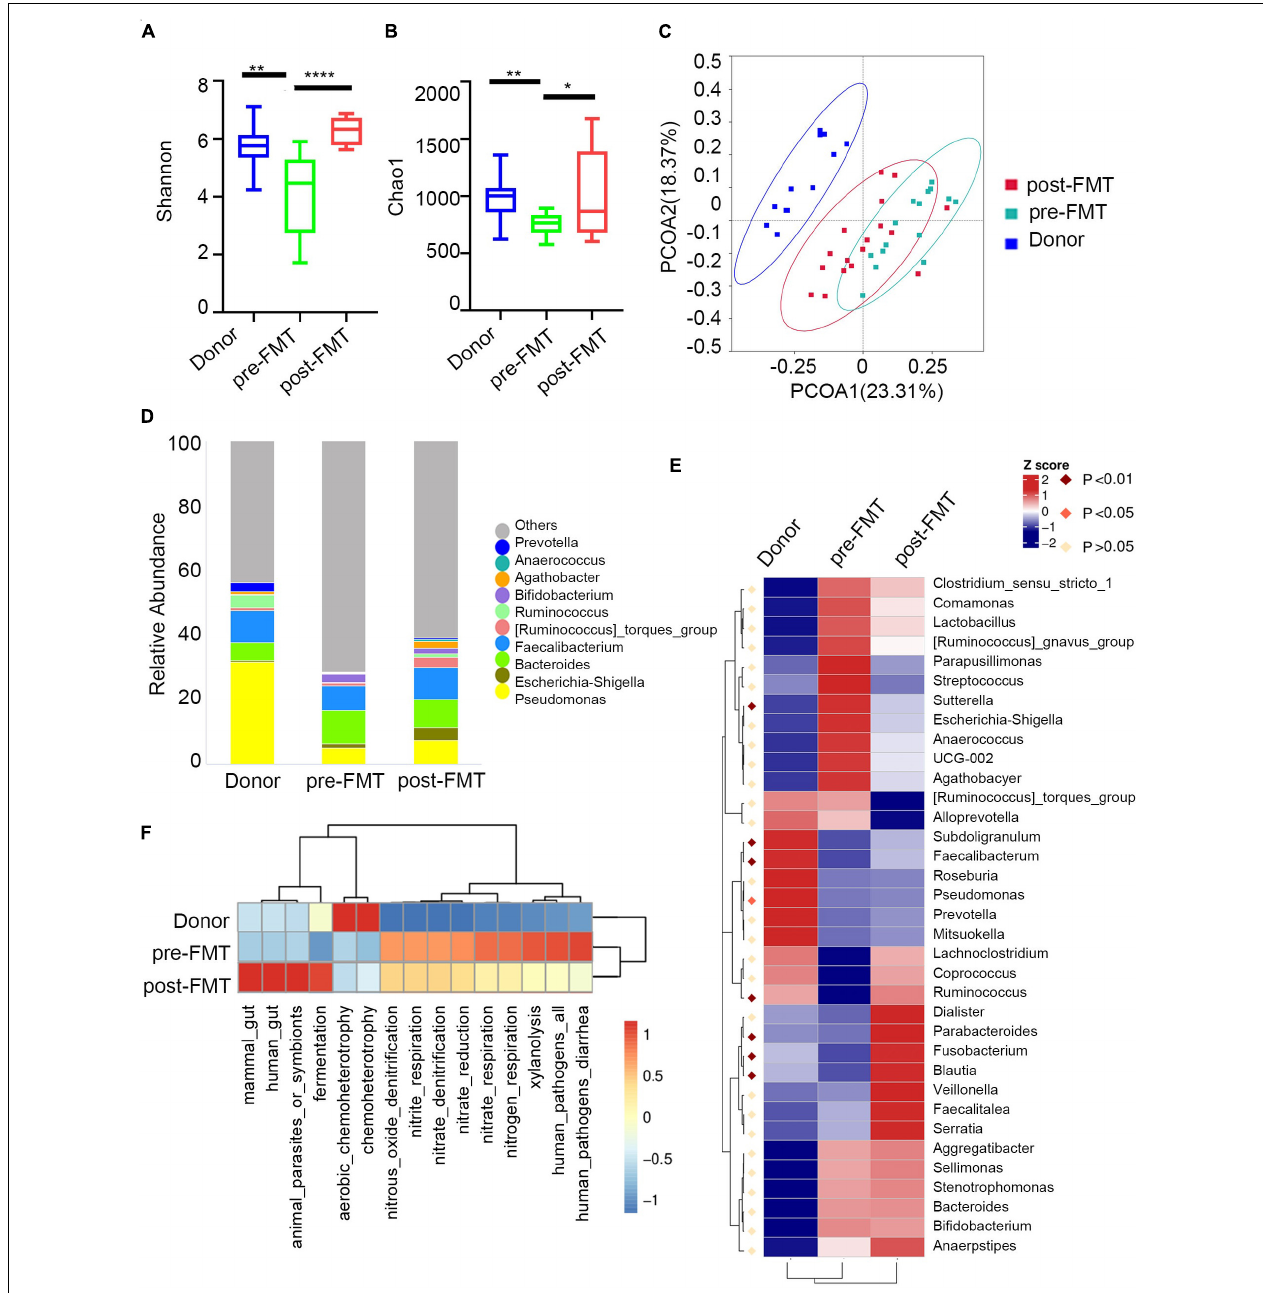
FIGURE 5 | Characteristics of IgA -bound bacteria before and after FMT. (A) Shannon index. (B) Chao1 index. (C) PcoA index. (D) Heatmap analysis of the difference in genera of the gut microbiota pre/post FMT by Metastat. (E) Stacked bar plot of the genus structure in pre/post FMT. (F) Heatmap analysis of the function prediction among pre/post FMT. * p < 0.05, ** p < 0.01, **** p < 0.0001, ns means no significance